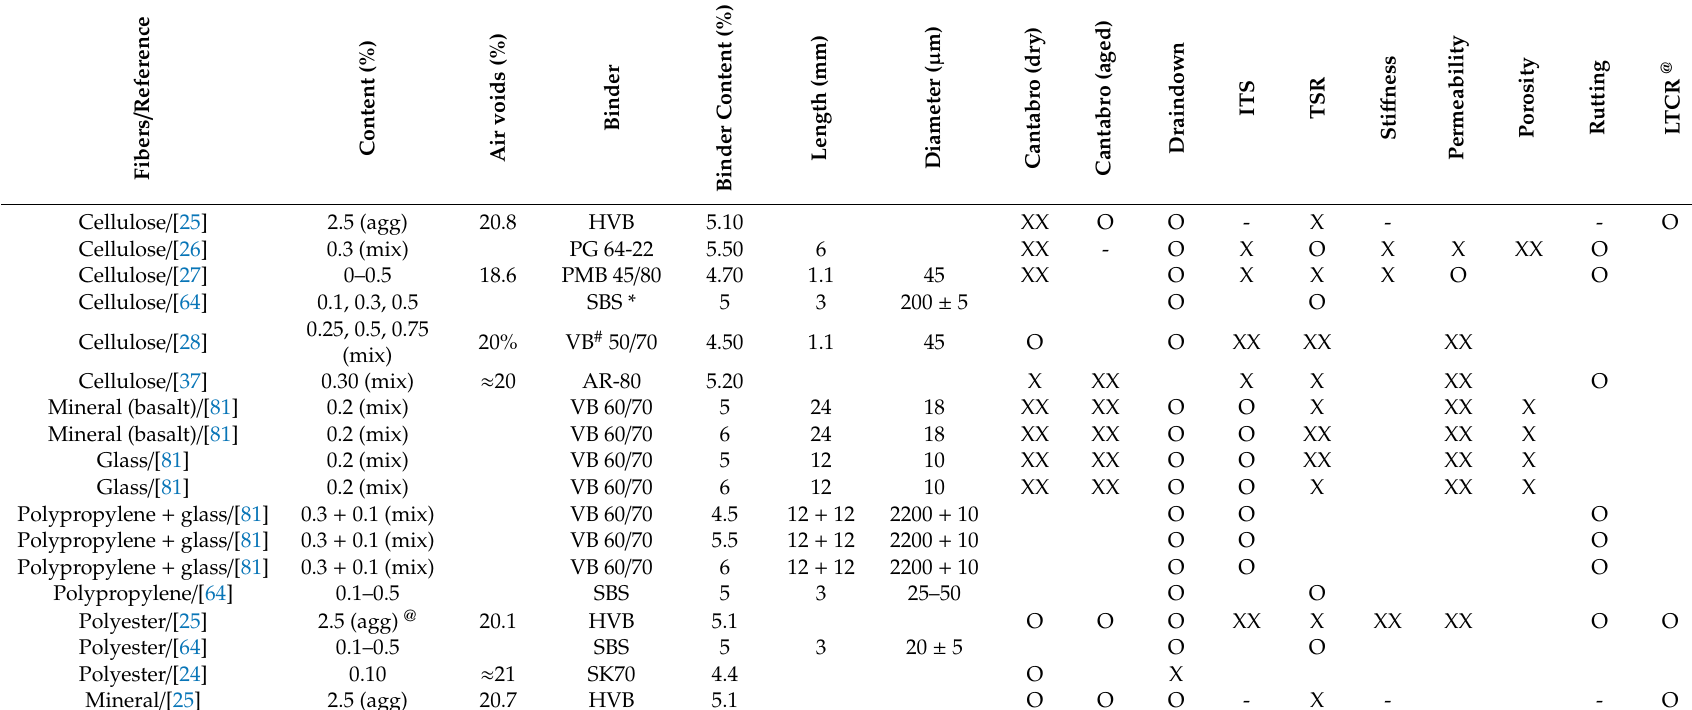
Table 3. Comparison of performance of fibers in